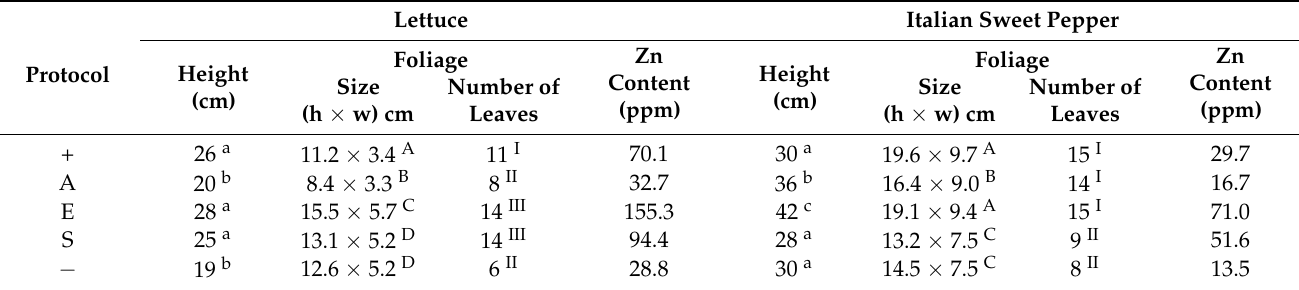
Table 5. Characteristics of crops fertilized with the different matrices (A, E, S), by conventional fertilization (+) or without fertilization ( − ). Different letters and roman numerals mean significant differences.